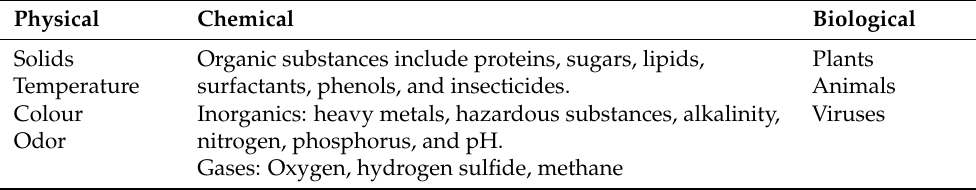
Table 1. Design factors consider wastewater’s physical, chemical, and biological